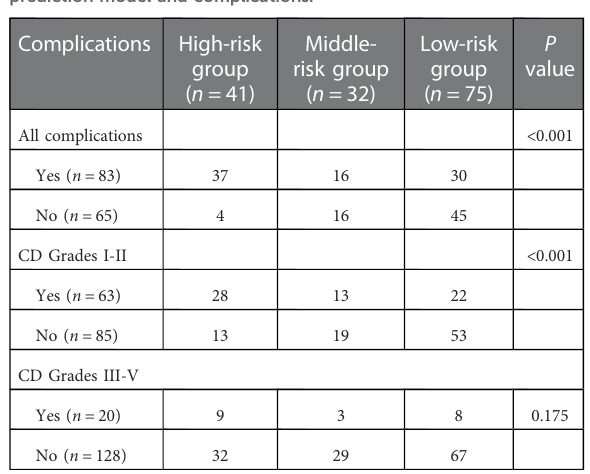
TABLE 5 Relationship between risk group established by the prediction model and